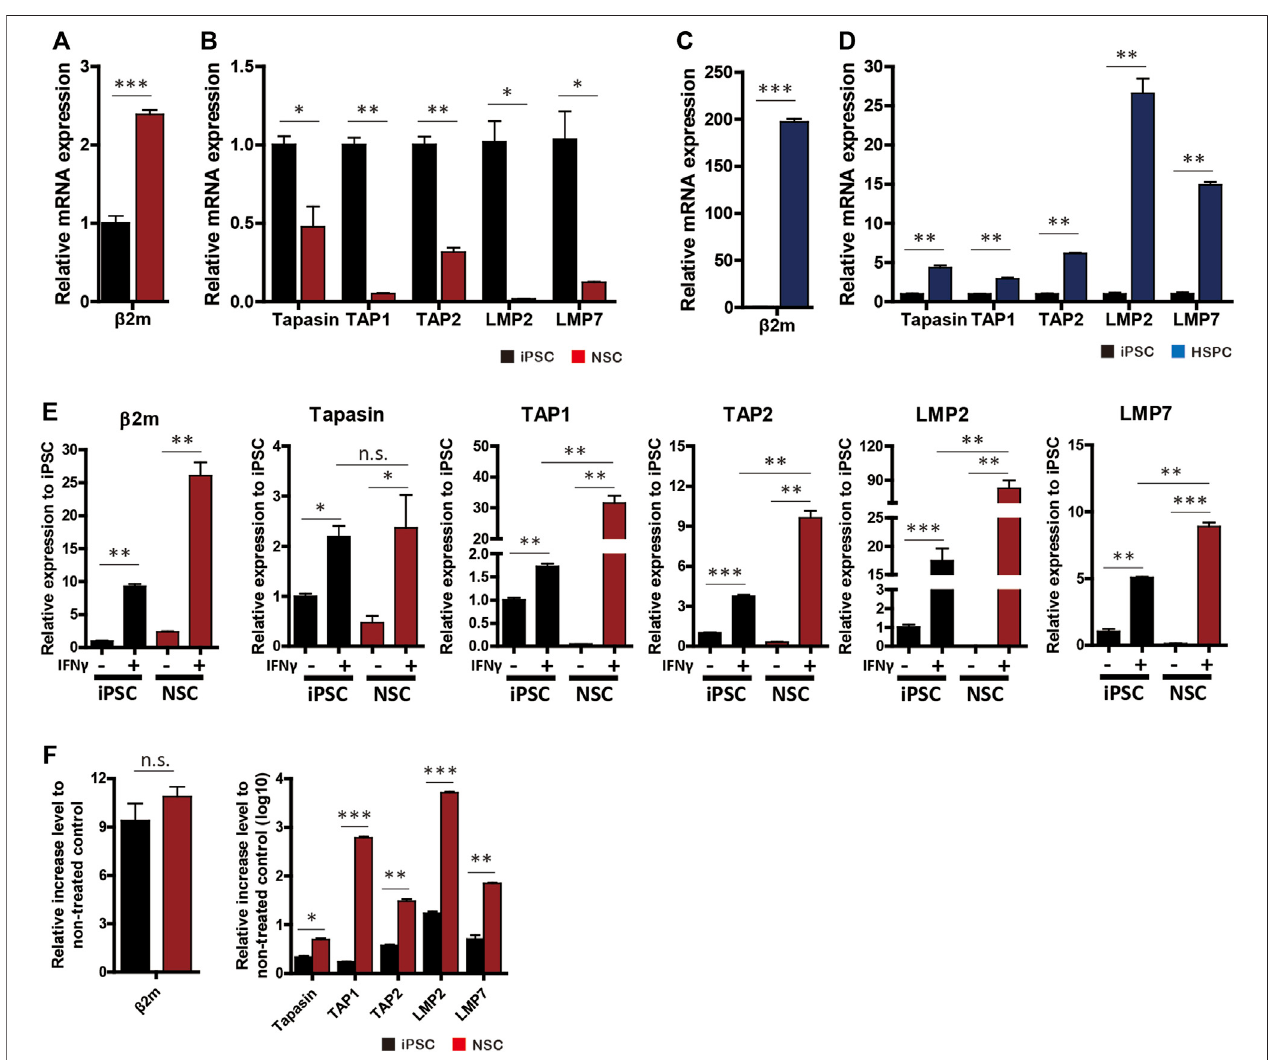
FIGURE 4 | APM gene expression pro fi les. (A – D) mRNA levels of β 2m and APM genes (tapasin, TAP1, TAP2, LMP2, and LMP7) in neural-lineage cells (A,B) and hematopoietic-lineagecells (C,D) incomparisonwithiPSCs( n =4). (E) β 2mandAPMexpressionpatternsiniPSCsandNSCsinresponseto48 hofIFN- γ treatment( n = 4). (F) Rate of increase in gene expression after IFN- γ treatment ( n = 4). Data are means ± SEMs. n.s., not signi fi cant. * p < 0.05, ** p < 0.01, *** p <